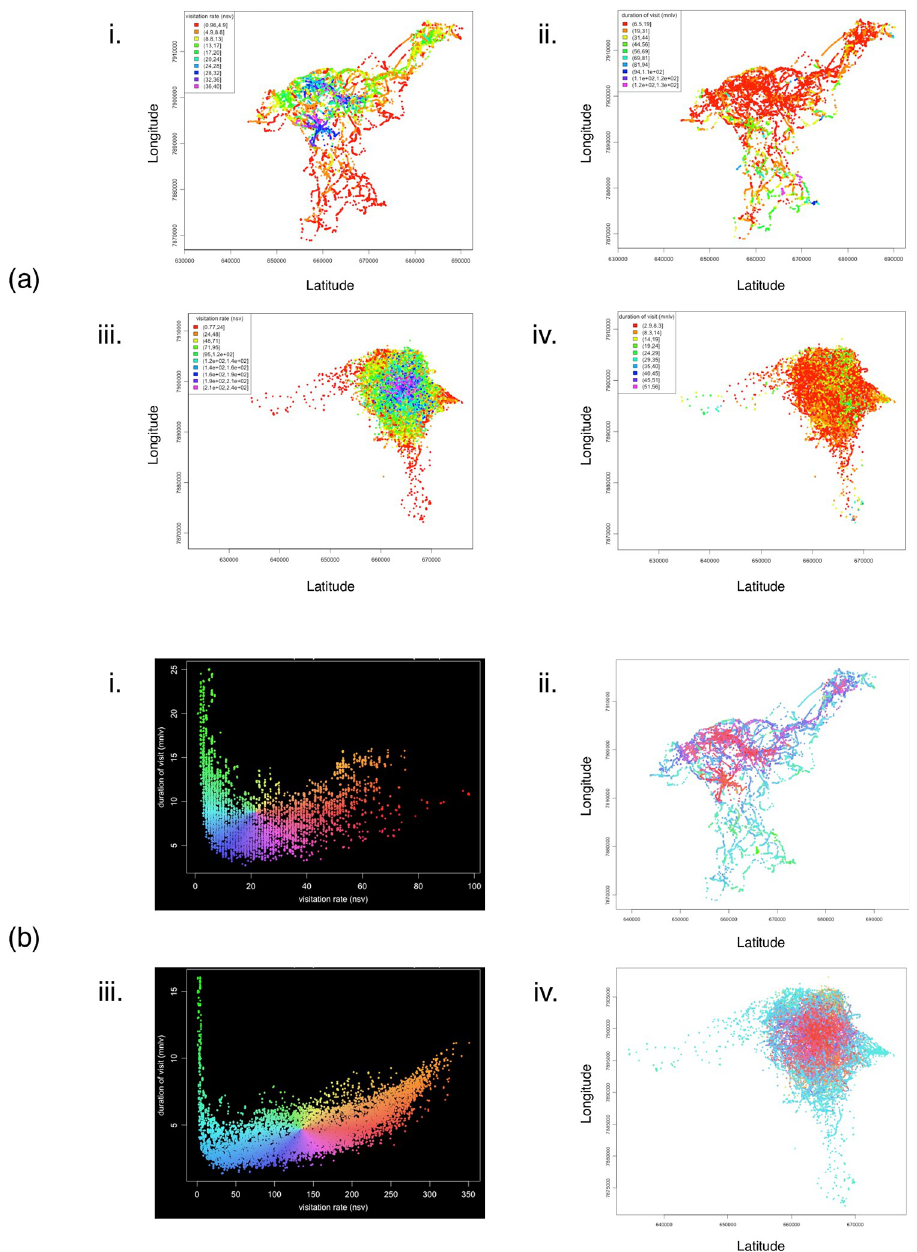
Fig 2. Revisitation and duration (RD) space plots indicated from the hull parent points of a lion and spotted hyena whose ranges overlapped. (a) Hull parent points for a collared female lion (NU-33865, i & ii, both figures) and female spotted hyena (GO-33869, iii & iv, both figures) whose ranges overlapped in Etosha. Parent points are colored by visitation rate (nsv, number of separate visits; i & iii), and duration of visit (mnlv, mean number of locations in the hull per visit; ii & iv). (b) RD space scatterplots (i & iii) with X-axis = visitation rate (nsv), and Y-axis = duration of visit (mnlv), provide a legend for revisitation/duration (RD) values for the maps (ii & iv). Points in the RD space have been jiggled to better see point density, and each point within the RD space represents a hull (i) lion n = 9160, (iii) hyena n = 11898. Points on the maps (ii & iv) are colored by their location in the RD space. Separate visits defined by an inter-visit gap period � 12 hours. Hulls were created using the adaptive method. Duplicate points are offset by 1 map